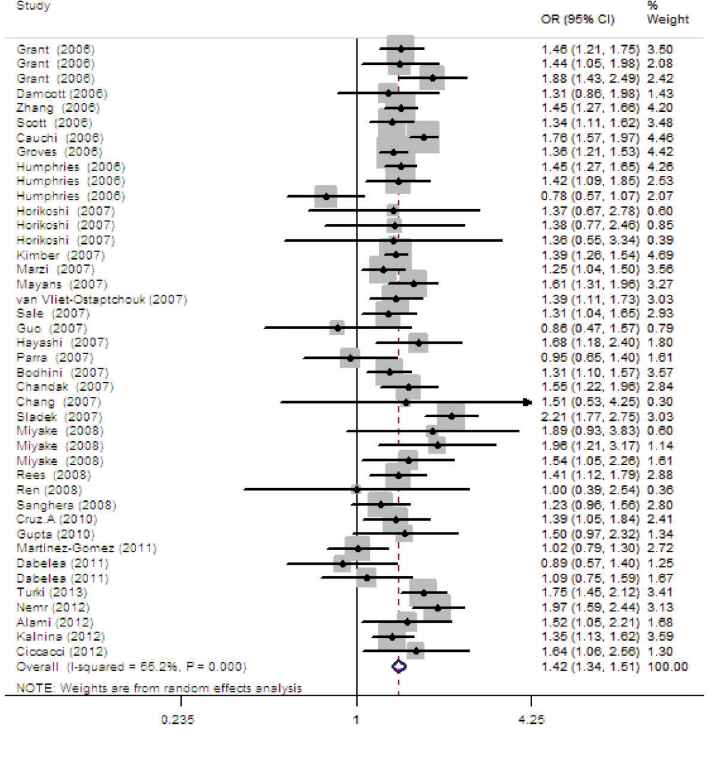
Figure 5. Meta-analysis of the associa- tion between type 2 diabetes and the recessive model of